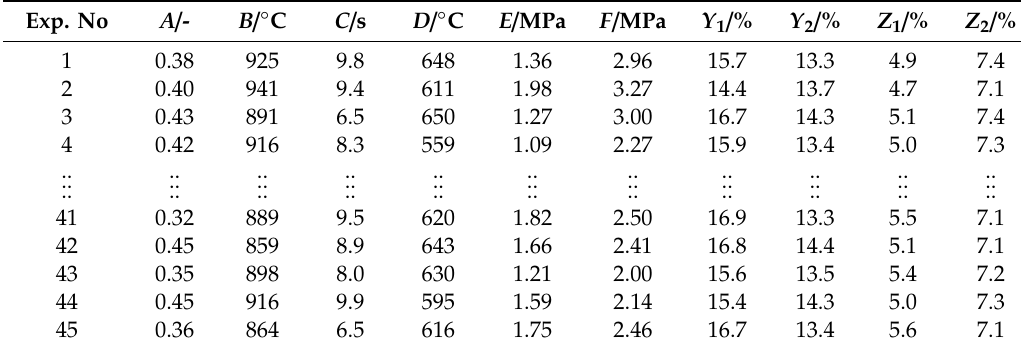
Table 4. The schemes and simulation